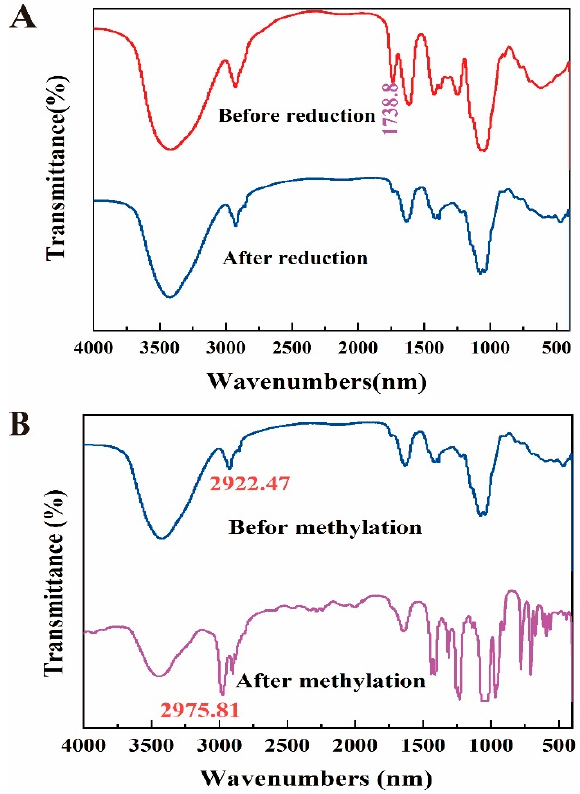
Figure 2. ( A ) FT-IR spectra of DLP120 before and after reduction. ( B ) FT-IR spectra of DLP120 before and after methylation. Table 1. GC-MS of alditol acetate derivatives from the methylated products of DLP120.